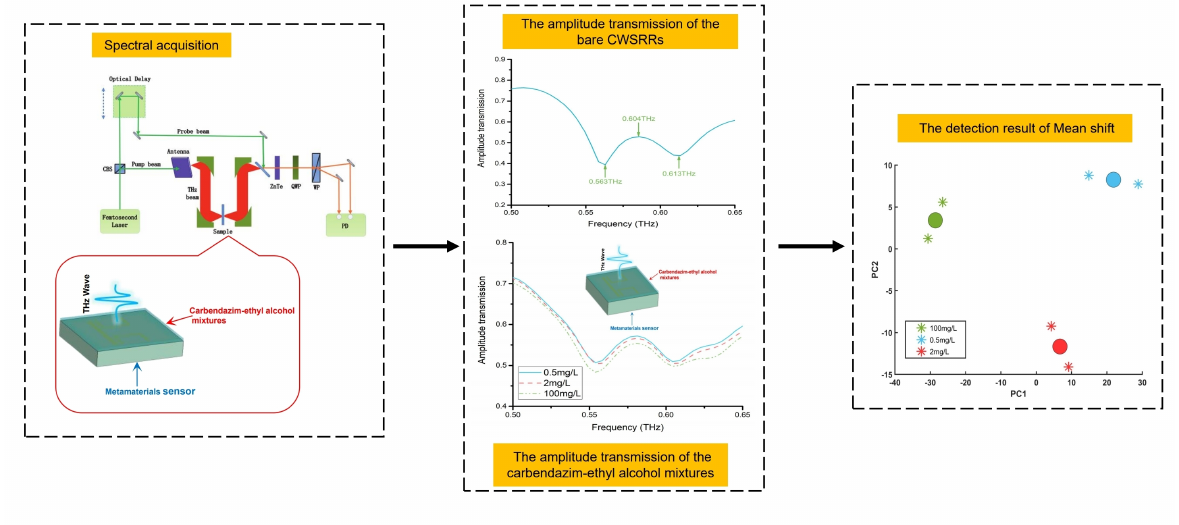
Figure 8. The flow chart for the experiment